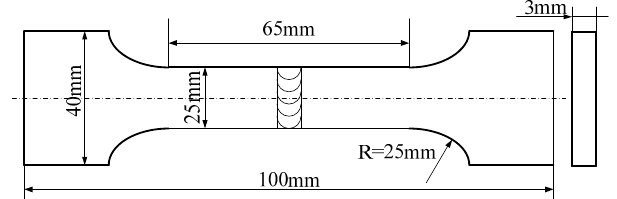
Figure 3. Dimensions of the tensile test specimen.